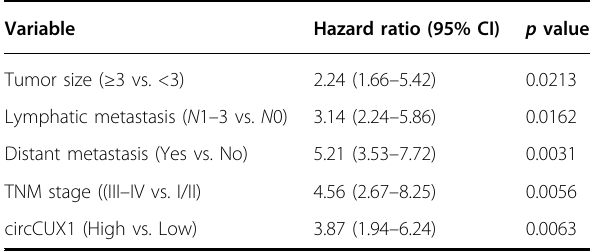
Table 3 Univariate analysis of prognostic factors of HPSCC.